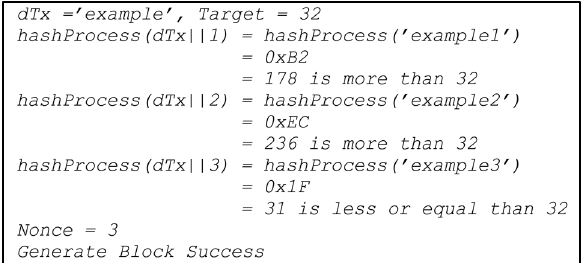
Figure 3. Examples of hashing processes in creating blocks on a